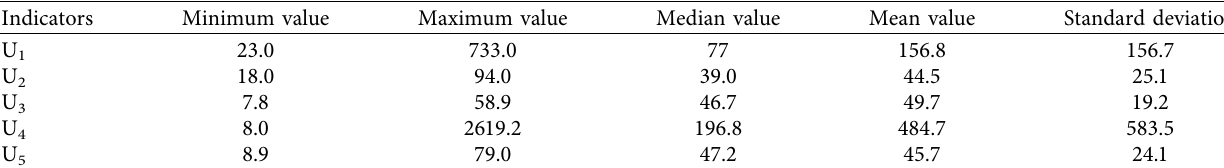
Table 5: Results of data characteristics of input and output variables for 2018 and